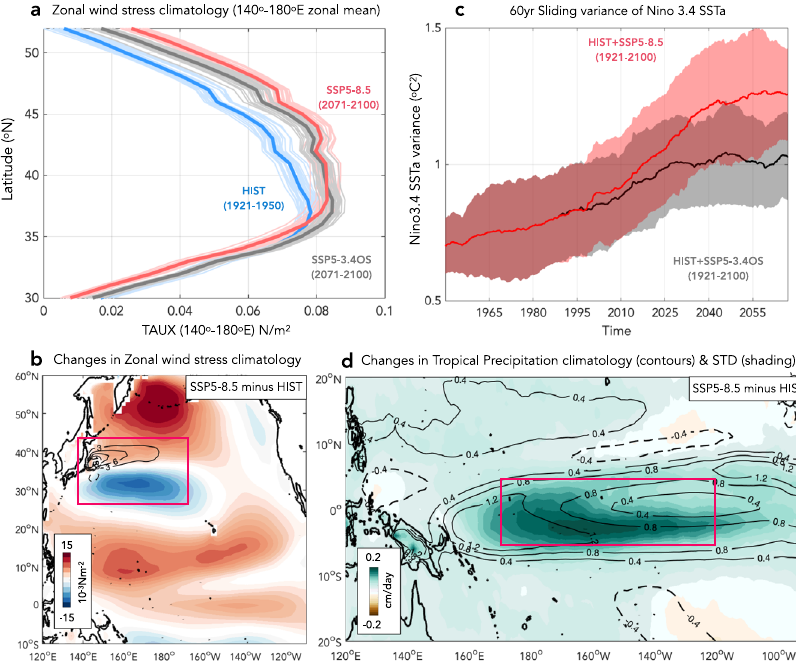
Fig. 2 Climate response to changing greenhouse gas concentrations. a Zonal mean surface wind stress of the North Paci fi c midlatitude over the earlier and later time periods of 30 year epochs from HIST (1921 – 1950, blue), SSP5-3.4OS (2071 – 2100, gray), and SSP5-8.5 (2071 – 2100, pink) runs. Thick lines represent the ensemble mean, and thin lines the individual members. b Change in zonal wind stress climatology from HIST to SSP5-8.5. Contours show SSH anomalies regressed on the KE index over the period between 1921 – 2100. The pink box covering the western boundary current system indicates the zone of intensi fi ed Ekman convergence (strengthened anti-cyclonic surface winds). c 60-year sliding variance of Nino3.4 SST anomalies ( o C 2 ) in HIST + SSP5-8.5 (pink) and HIST + SSP5-3.4OS (gray) ensemble simulations. The moving windows are computed by skipping a month. The solid line represents the ensemble mean and shading indicates a 90% con fi dence interval based on the Bootstrapping test (see Methods). d Changes in annual mean climatology (contours, cm/day) and monthly anomaly standard deviation (shading, cm/day) of the tropical Paci fi c precipitation from HIST to SSP5-8.5. The pink box denotes the Nino3.4 region [5°S – 5°N, 120° –